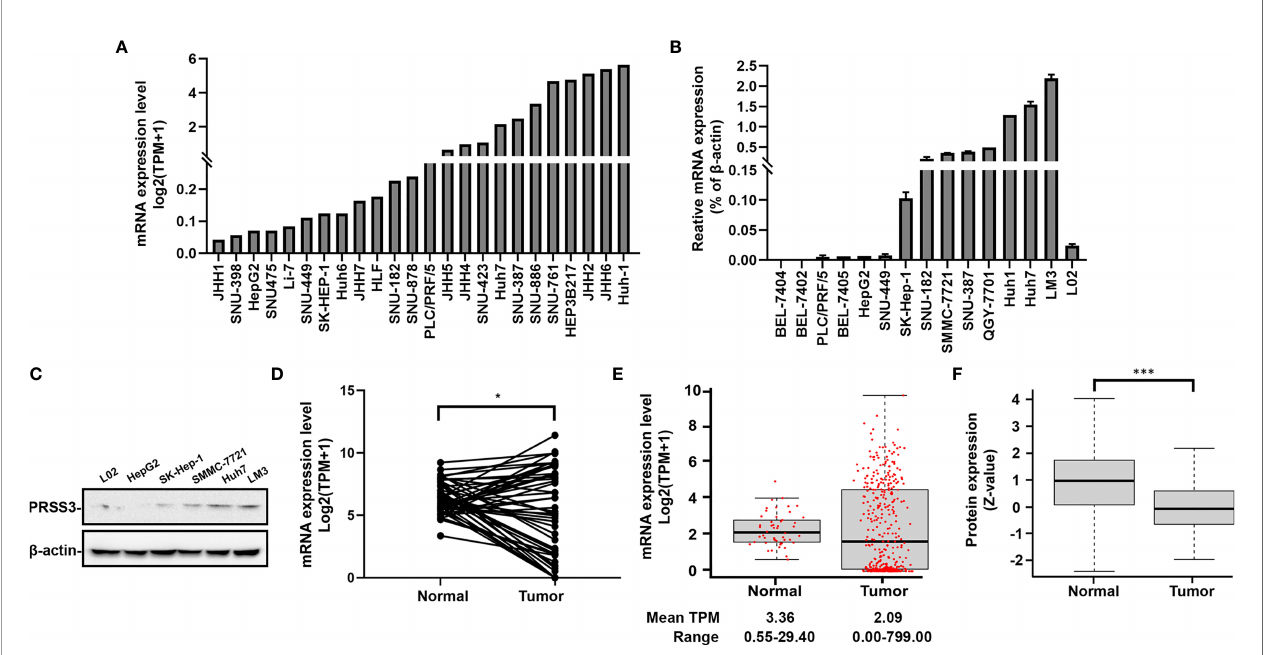
FIGURE 1 | PRSS3 expression in human HCC cell lines and tissues. (A) The mRNA level of PRSS3 expression in 24 HCC cell lines using RNA-seq data extracted from the DepMap website. The expression bar chart is sorted by PRSS3 mRNA expression levels processed on a log2 (TPM+1) scale. TPM: transcripts per million. (B) RT – qPCR analysis of PRSS3 expression in 14 HCC cell lines and the human fetal liver cell line L02. The relative expression of PRSS3 mRNA was normalized to b -actin , presented as the mean ± SD from three independent experiments performed in triplicate. (C) Western blot analysis of PRSS3 in HCC cell lines and L02 cells. (D, E) The RNA-seq data were sourced from FIREHOSE ( Table 1 ). PRSS3 expression in 50 pairs of tumors and matched solid normal tissues from patients with HCC (D) or extensively in 371 tumor samples versus 50 normal tissues from HCC patients (E) . * P < 0.05, by Student ’ s t test. (F) PRSS3 protein expression in human HCC (n = 165) in comparison with normal liver tissues (Normal) (n = 165), based on data from UALCAN portal analysis of CPTAC Con fi rmatory/Discovery dataset. Z-values represent the standard deviation from the median across samples for a given cancer type. Log2 spectral count ratio values from CPTAC were fi rst normalized within each sample pro fi le and normalized across samples. *** P < 0.001, by the Wilcoxon rank sum test.